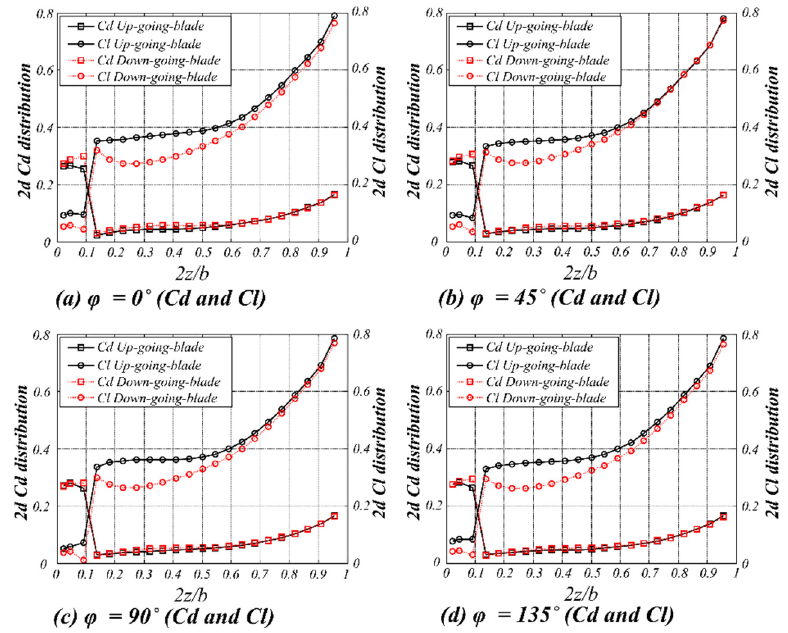
Figure 9. Instantaneous C l , C d distribution at various propeller azimuth angles at ω = 555 rad/s, (a to d) lift and drag coefficient distribution along the wing span with changing of propeller azimuth angle from 0 ° 𝑡𝑜 135 ° .